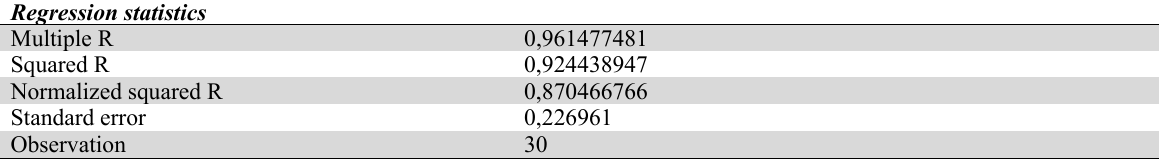
Correlation ratio